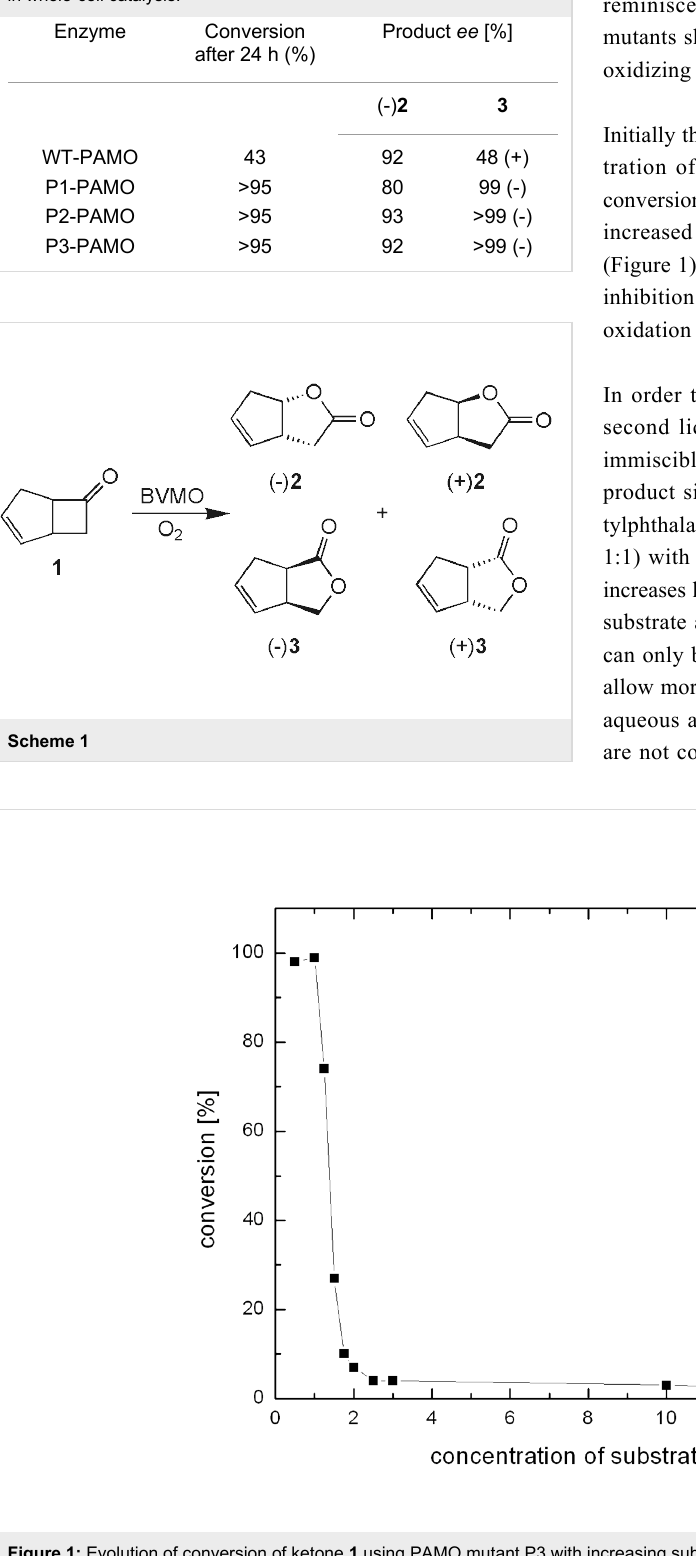
Figure 1: Evolution of conversion of ketone 1 using PAMO mutant P3 with increasing substrate concentration in whole-cell catalysis.